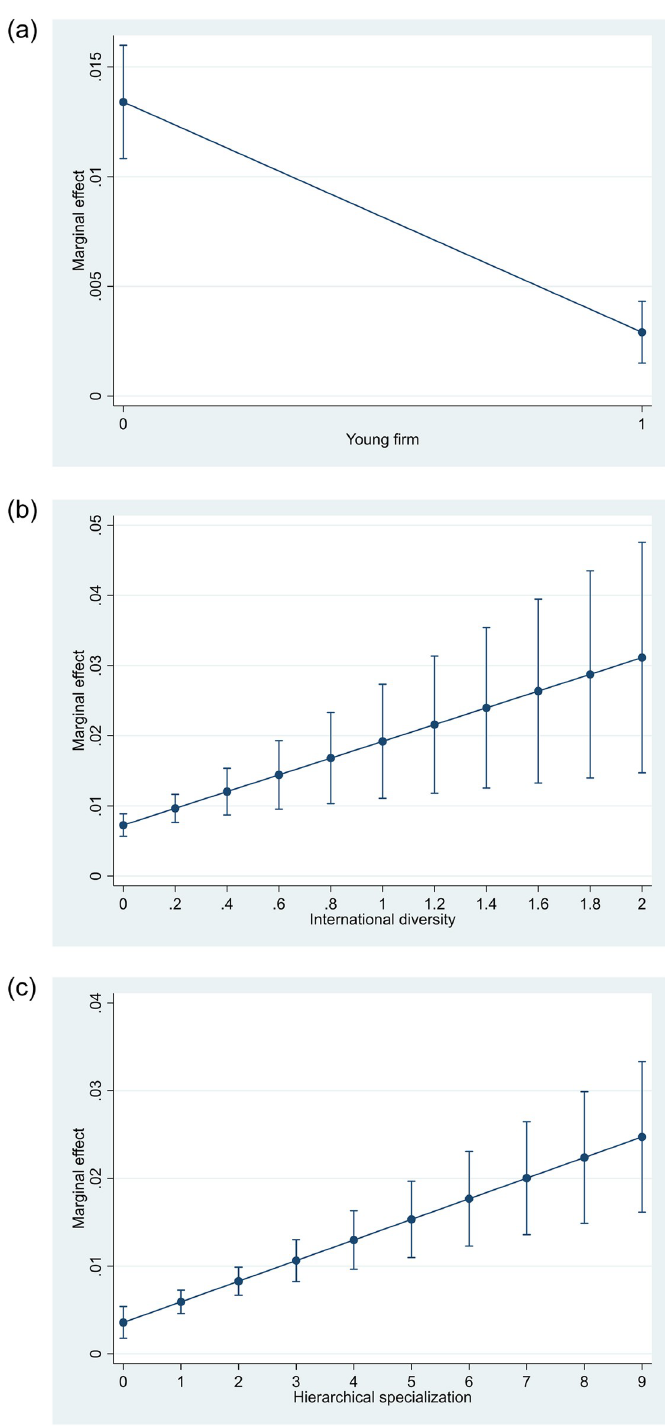
Fig 1. a–c Visual representation of the moderation effects (with 95%-confidence intervals).